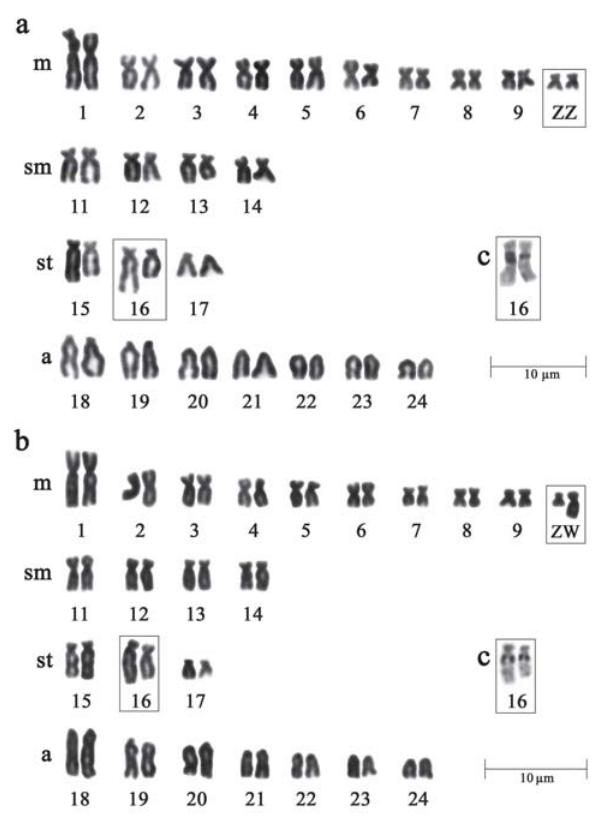
Fig. 2. Karyotypes of male (a) and female (b) Ancistrus ranunculu s after conventional Giemsa-staining, evidencing the sex chromosomes (box) and the NOR-bearing chromosomes after silver-staining (c). m= metacentric; sm= submetacentric; st= subtelocentric; a=